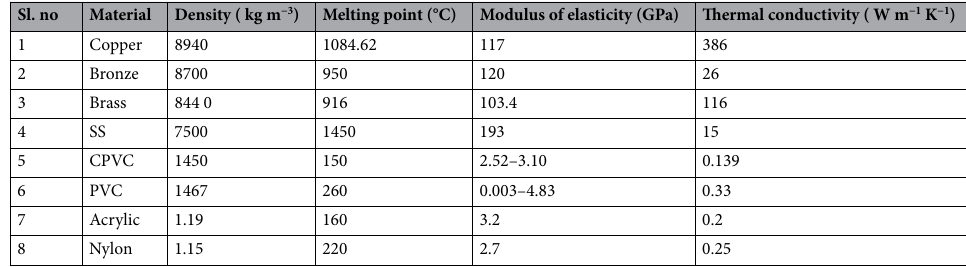
Table 2. Materials proprties of different materials used in the present research work.